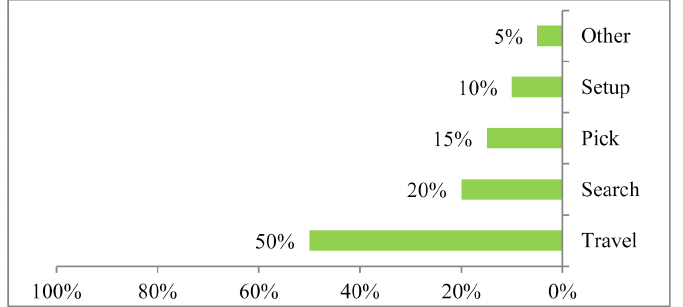
Figure 8. Distribution Percentage of Order picker Time Types